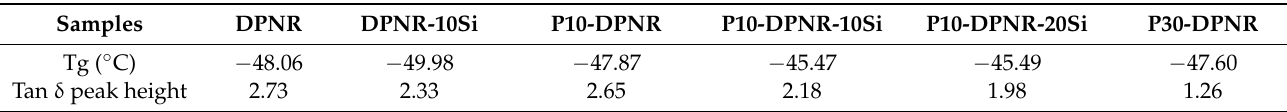
Figure 17. ( a ) Storage modulus: inset; storage modulus of silica-filled P10-DPNR as a function of silica content; ( b ) loss tangent (tan δ ) of silica-filled natural rubber composites as a function of temperature. Table 5. Viscoelastic properties of vulcanizates.